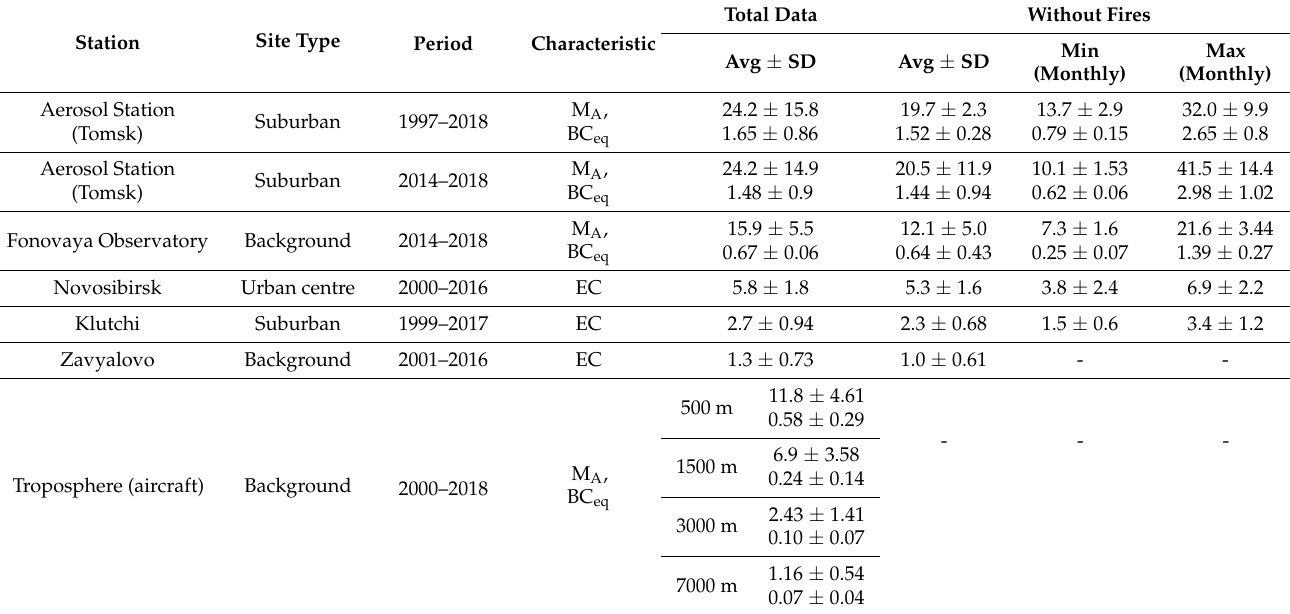
(2.7 ± 0.8 mg/m 3 ) was revealed in January, and the minimal was found (0.79 ± 0.15 µ g/m 3 ) in June. Over the last 5 years, the maximum in seasonal oscillations increased to 3 ± 1 µ g/m 3 and shifted toward February, and the minimum of 0.62 ± 0.06 µ g/m 3 shifted toward May. Under the background conditions in this same period, the maximal seasonal variations in the BC eq concentration were detected in these same months, with values of 1.4 ± 0.3 µ g/m 3 and 0.25 ± 0.07 µ g/m 3 , respectively. Thus, the maximal contribution of black carbon from urban sources over the period of 2014–2018 at the Aerosol Station was recorded in February—the BC eq concentration was 1.6 µ g/m 3 larger than at the Fonovaya Observatory, with a minimal difference of 0.37 µ g/m 3 recorded in